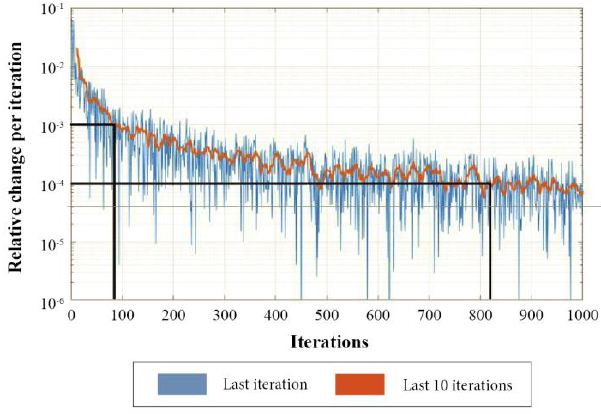
Figure 8. Relative change in the average occupancy per iteration.